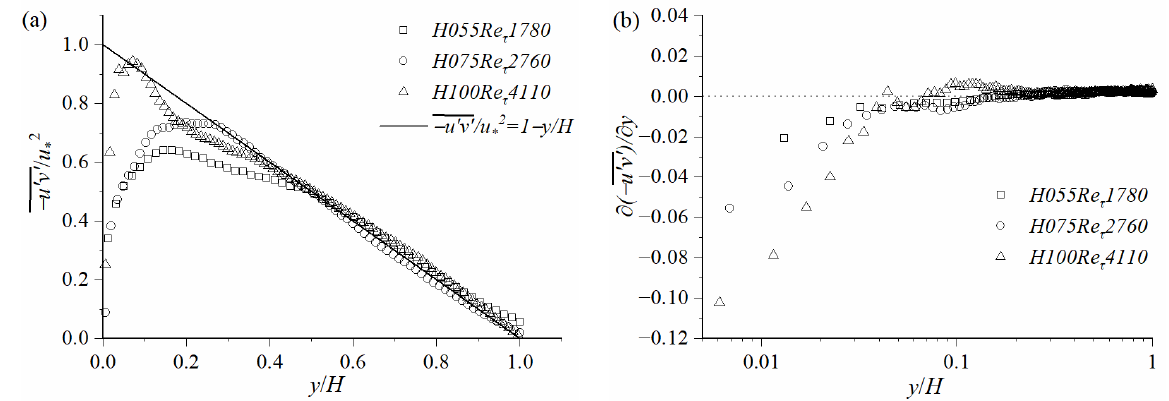
Figure 4. Wall-normal profiles of ( a ) the Reynolds shear stress and ( b ) the net force.